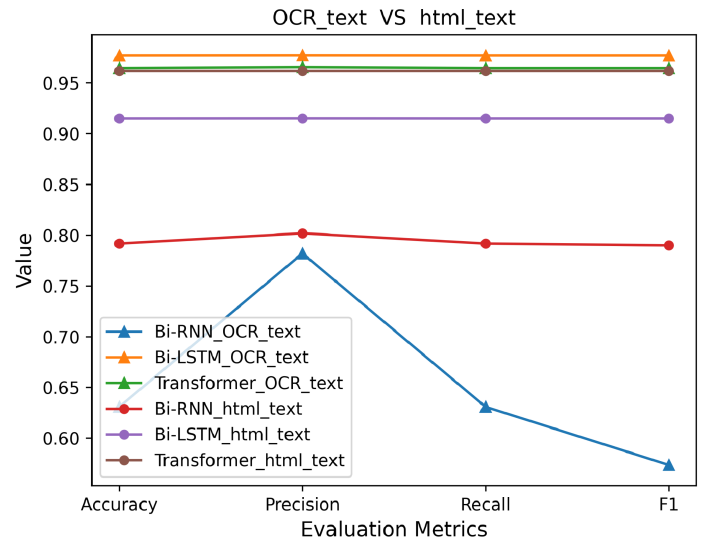
Figure 9. Results on OCR text and html